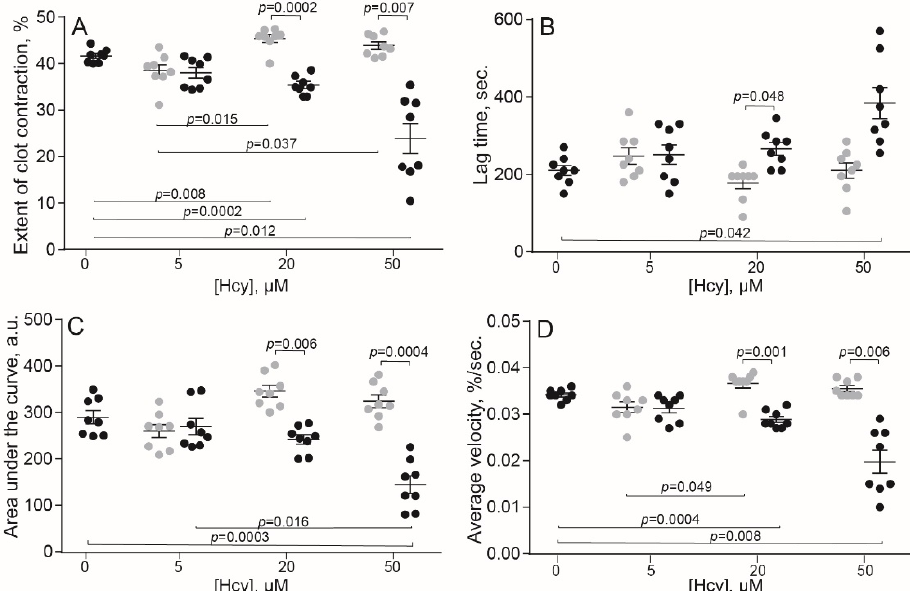
Figure 1. Parameters of clot contraction in in vitro clots made from normal human blood without or with addition of exogenous Hcy in vitro ( n = 9). Grey dots: 1-min pre-incubation with Hcy; black dots: 15-min pre-incubation with Hcy before the clot contraction assay. Parameters analyzed: extent of contraction ( A ); lag time ( B ); area under the contraction kinetic curve—work done by platelets ( C ); average contraction velocity ( D ). Mean ± SEM, repeated measures ANOVA, post-hoc Tukey’s test. Only significant differences are shown ( p < 0.05).